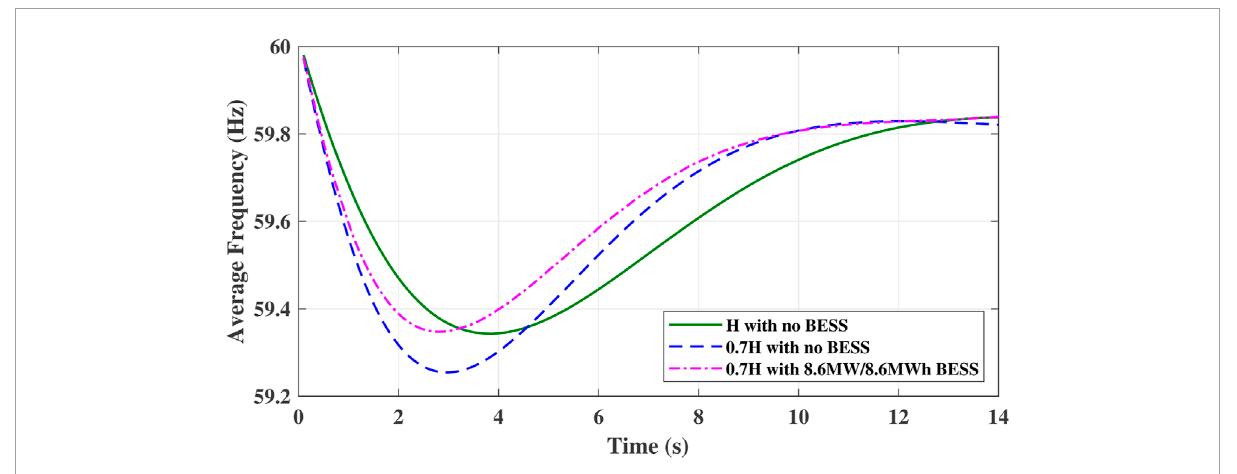
FIGURE 11 The effect of virtual inertia from BESS on frequency